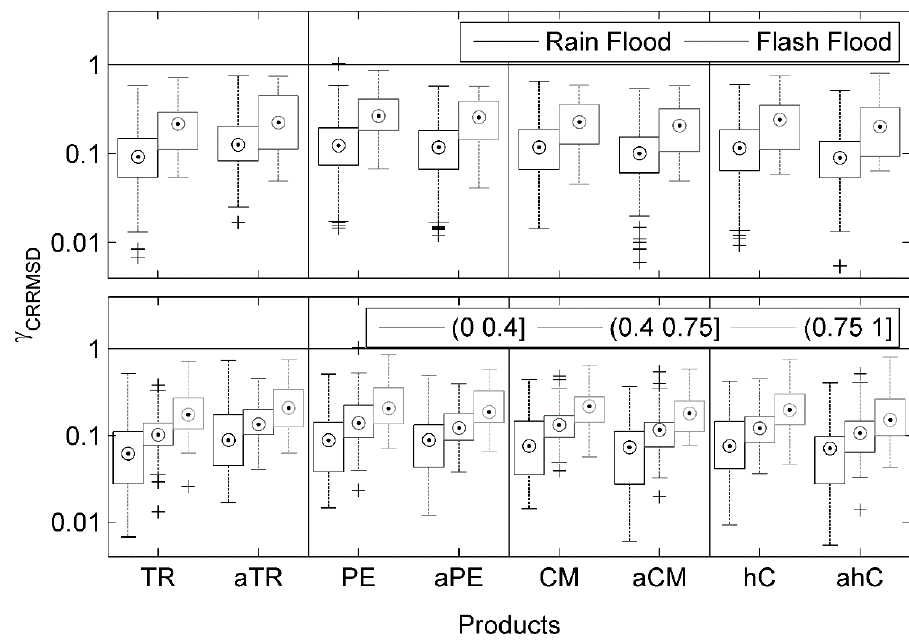
Figure 8. Ratio of centered relative root mean square difference sorted according to flood type ( top panel ) and runoff coefficient ( bottom panel ). Cross corresponds to outlier and circles represent median.